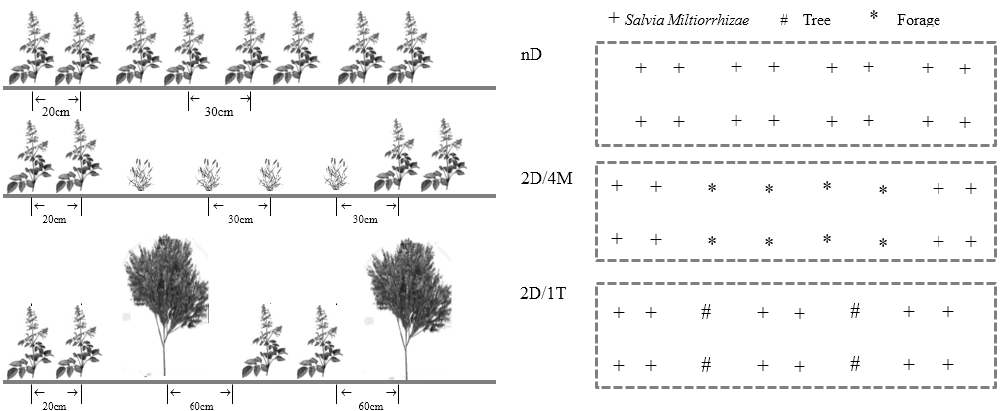
Figure 2. Diagram of planting pattern. Table 2. The physical and chemical properties of the